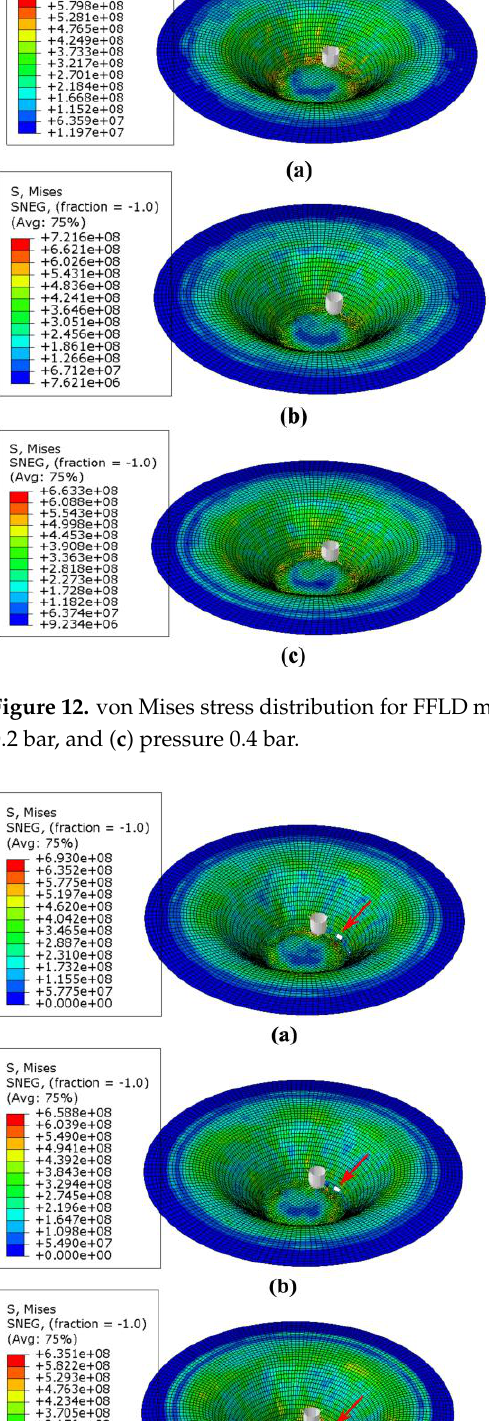
Figure 11. Blank deformation and deformed mesh over various stages (initial stage on left and final stage on right) of PA-SPIF.